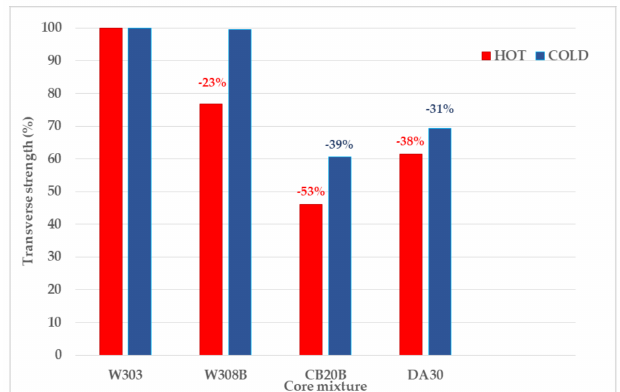
Figure 6. Comparison of relative values of cold and hot transverse strengths of tested mixtures (relative to the mixture with the highest strengths—W303).